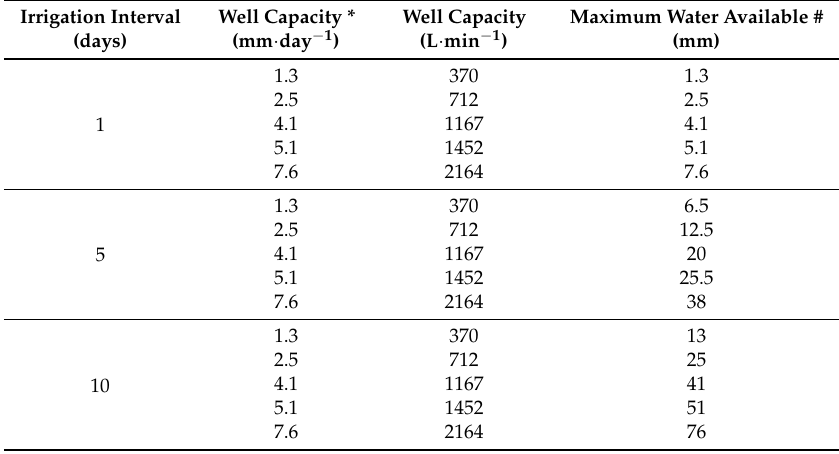
Table 1. Water applied for the selected three irrigation intervals and five well capacities for four sites across the Texas High